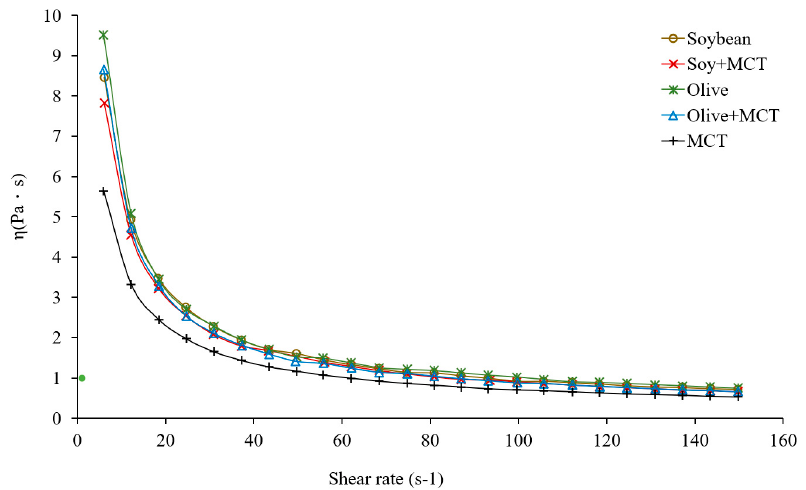
Figure 1. Steady shear viscosity curve of the mayonnaise samples. ( ○ ) Soybean oil; (×) soybean oil + (cid:35) oil + medium-chain triglycerides; ( ∗ ) olive oil; ( (cid:52) ) olive oil + medium-chain triglycerides; and (+) medium-chain triglycerides; ( ✽ ) olive oil; ( △ ) olive oil + medium-chain triglycerides; and (+) me-